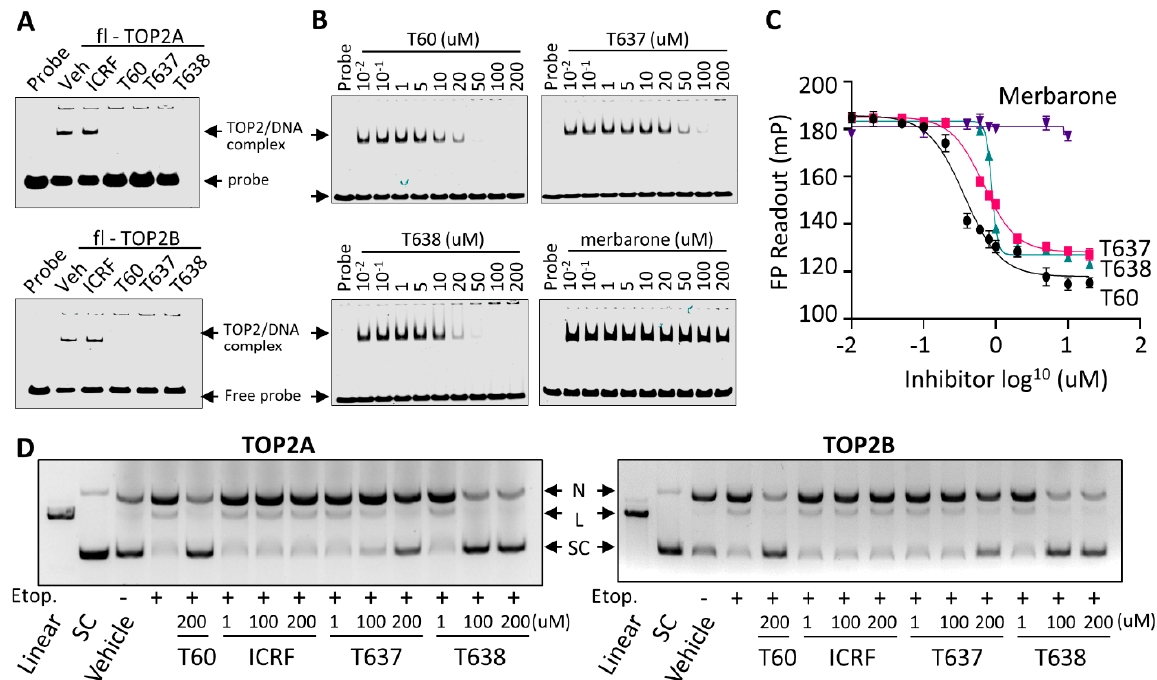
Figure 5. T637 and T638 block TOP2–DNA interaction and prevent TOP2 mediated DNA cleavage. ( A ) EMSA was performed by purified full-length TOP2A or TOP2B proteins at a contraction of 300 nM with IRDay700 labeled 5ZRF DNA oligo at a concentration of 100 nM in the presence of − /+200 µM of ICRF193, T60, T637, and T638. ( B ) EMSA was performed by incubating 2 uM of purified human TOP2A(431-1193) with 300 nM of IRDay700 labeled 5ZRF DNA oligo in the presence of − /+T60, T637, T638, or merbarone. ( C ) FP assay was performed by incubating 500 nM of the purified human TOP2A(431-1193) with 1 nM of 3’ 6-FAM labeled 5ZRF DNA oligo in the presence of 0.01–200 µM of T60, T637, T638, or merbarone. Reactions were subjected to fluorescence emission of 485 nm and excitation of 535 nm, which were detected by using the Multimode Microplate Reader (Infinite F500). ( D ) DNA cleavage assays were performed using full-length human TOP2A and TOP2B incubated with the supercoiled pHOT plasmid in the presence of 200 µM of etoposide plus 1, 100, or 200 µ M of ICRF193, T60, T637, and T638. Reactions were separated on a DNA gel with ethidium bromide. All experiments were repeated three times, and one representative image was shown. Note: N, nicked DNA; L, linear DNA; and SC, supercoiled DNA. Full Website Blot Figures are shown in the Supplementary